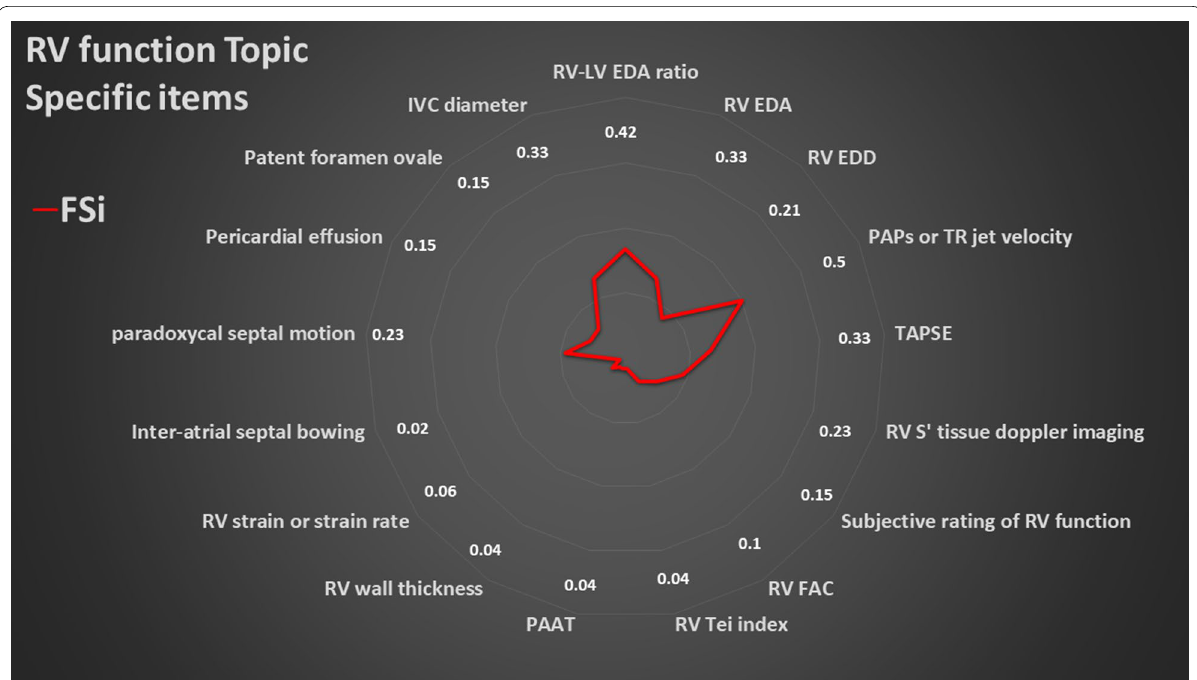
Fig. 4 Radar plot of the fraction of studies reporting an item (FSi) in the right ventricular (RV) function topic. IVC inferior vena cava, LV left ventricle, PAAT pulmonary acceleration time, PAPs pulmonary artery systolic pressure, RVEDA RV end‑diastolic area, RVEDD RV end‑diastolic diameter, RV FAC RV fractional area change, TAPSE tricuspid annulus systolic excursion, TR tricuspid regurgitation, S ʹ maximal systolic velocity by tissue Doppler imaging at the tricuspid annulus. As example, an FSi score of 0.42 for RV‑LV EDA ratio means that 42% of studies on RV function reported RV‑LV EDA